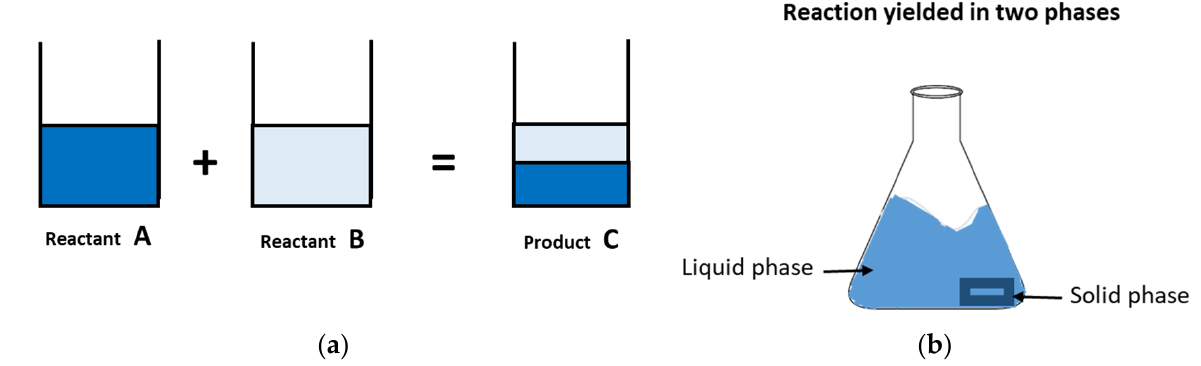
Figure 4. ( a ) Reaction resulting in an immiscible mixture, and ( b ) catalytic reaction in phases.